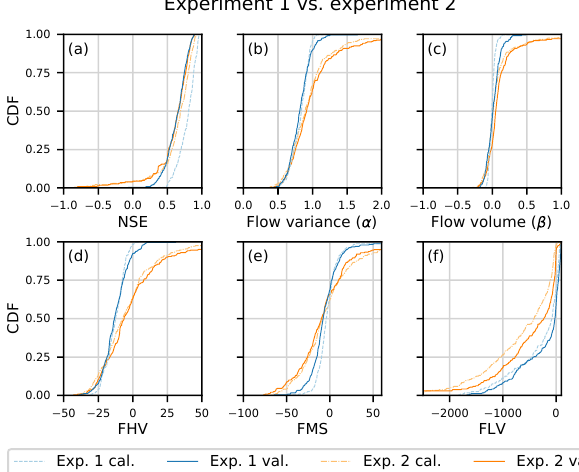
Figure 11. Cumulative density functions for several metrics of the calibration and validation period of the models from Experiment 1 compared to the regional models from Experiment 2. FHV is the bias of the top 2% flows, the peak flows, FMS is the slope of the middle section of the flow duration curve and FLV is the bias of the bottom 30% low